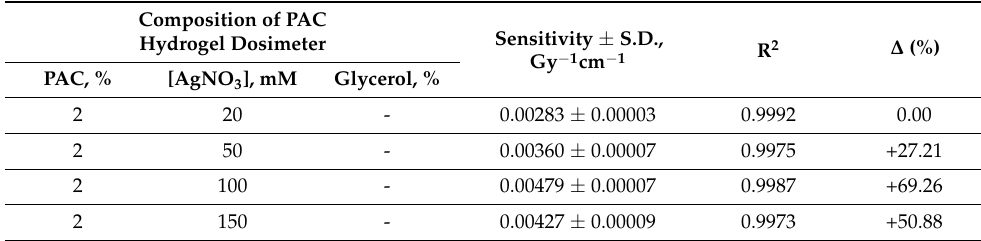
Figure 2. ( a ) illustrates the dose–response curve of silver nitrate PAC hydrogel dosimeter (2% PAC) at different AgNO 3 concentrations; net absorbance change at 453 nm as a function of absorbed dose (5–100 Gy). ( b ) shows the radiation sensitivity of silver nitrate PAC dosimeter as a function of [AgNO 3 ]. The solid red line is a guide for the eye obtained using a basis spline function. The error bars denote the standard deviation of the mean values. Table 2. Radiation sensitivity, correlation coefficient (R 2 ), and the percentage variation of response of PAC hydrogel dosimeters prepared using different concentrations of silver